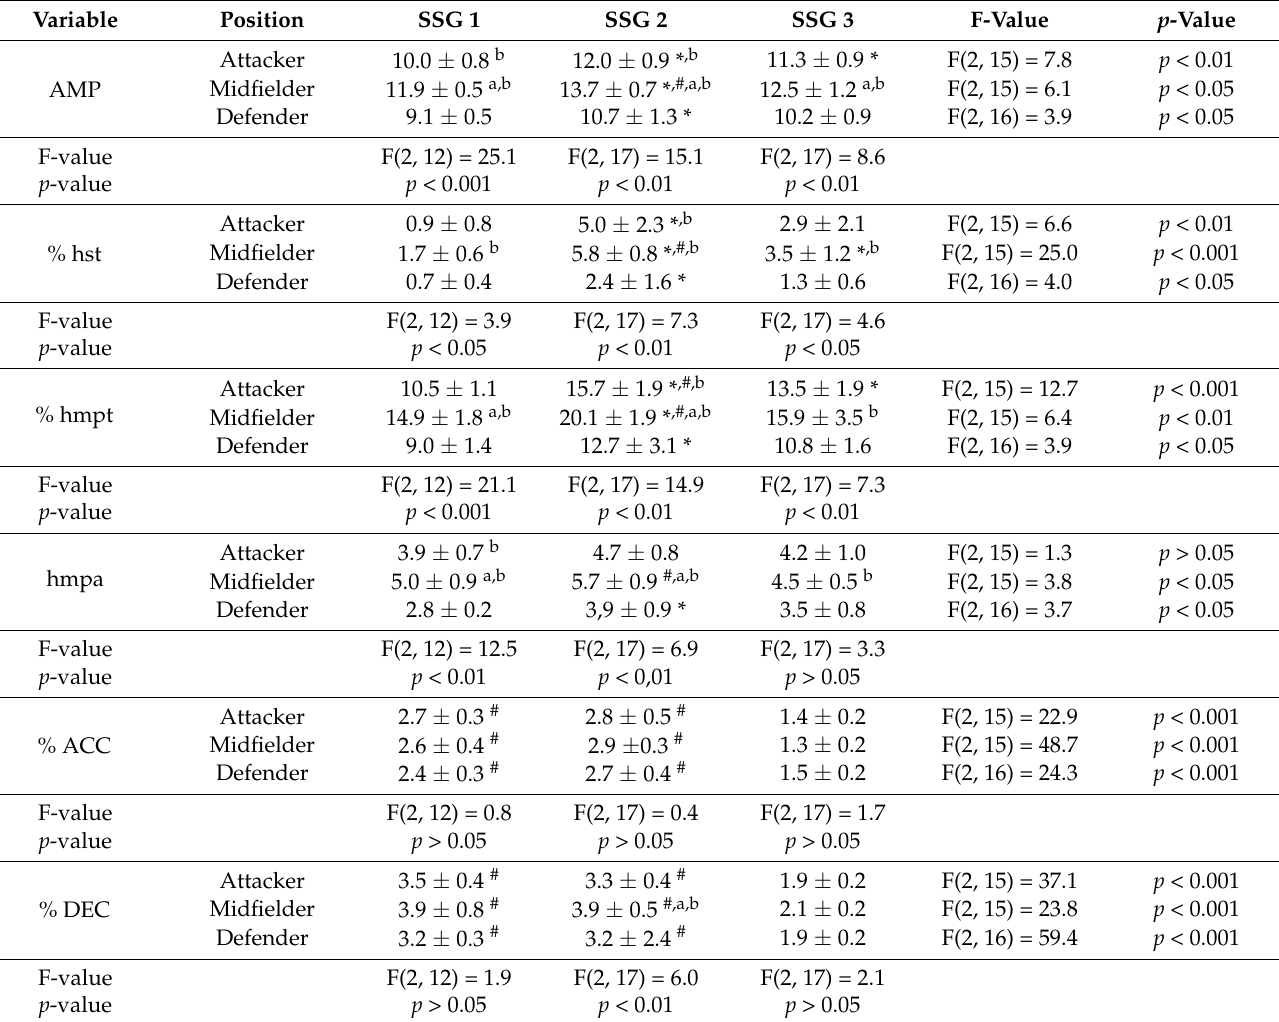
Table 3. Mean values ± SD of the variables recorded in the SSGs